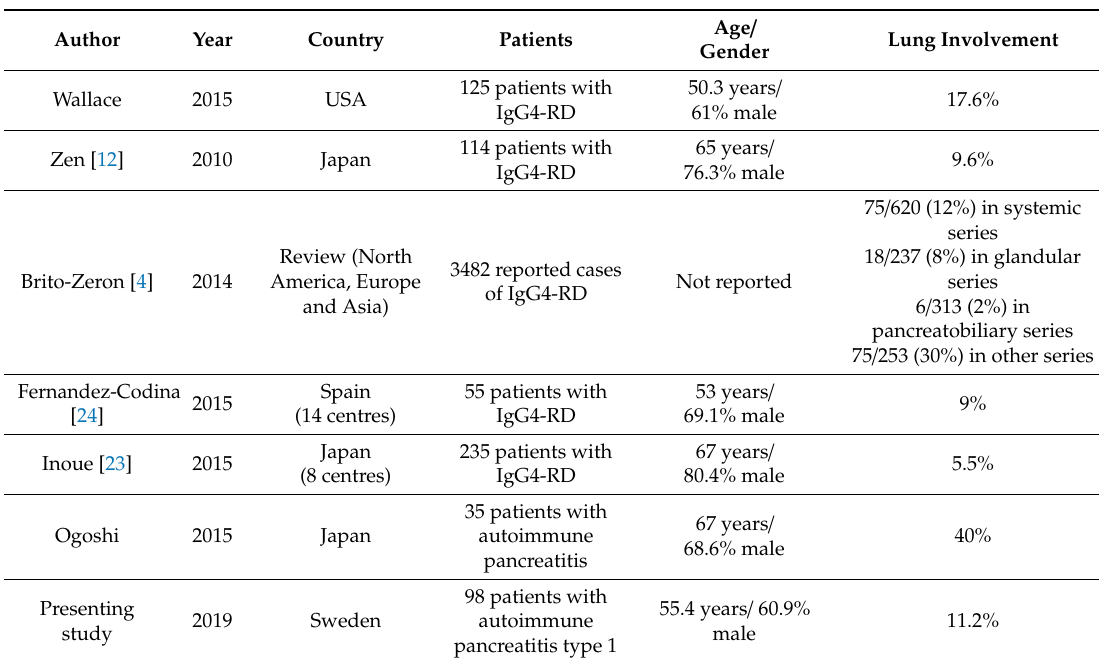
Table 5. Studies on lung involvement in patients with IgG4-related diseases